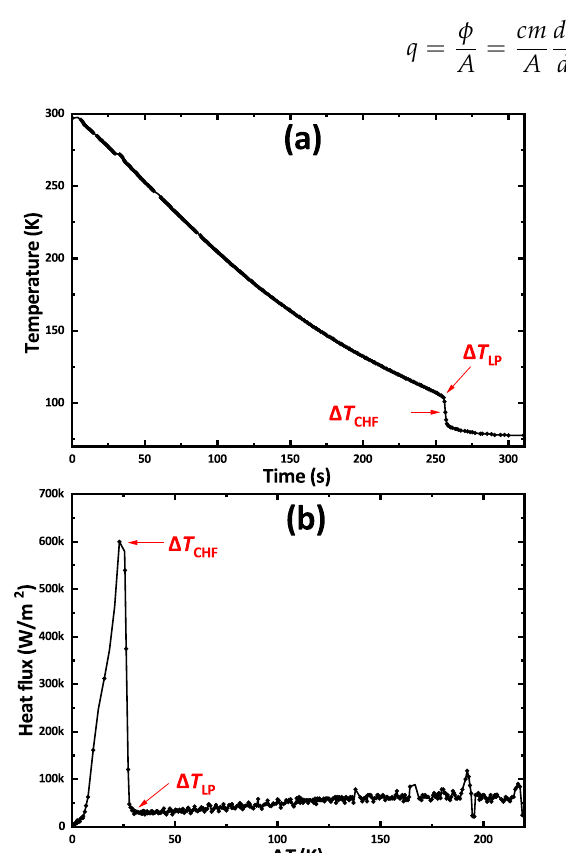
Figure 2. The typical ( a ) cooling curve and ( b ) boiling curve with ∆ T CHF and ∆ T LP